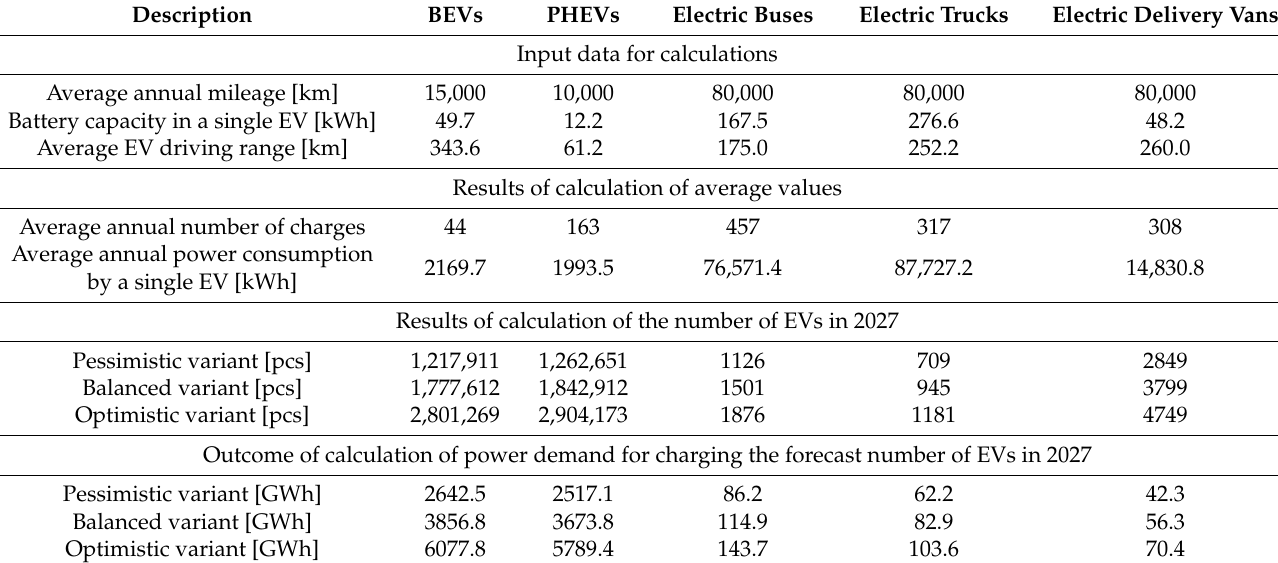
Figure 9. Diagram of calculation of forecasts of annual power demand resulting solely from the operation of the forecast number of electric vehicles. Table 4. Input data and calculation results for 2027.